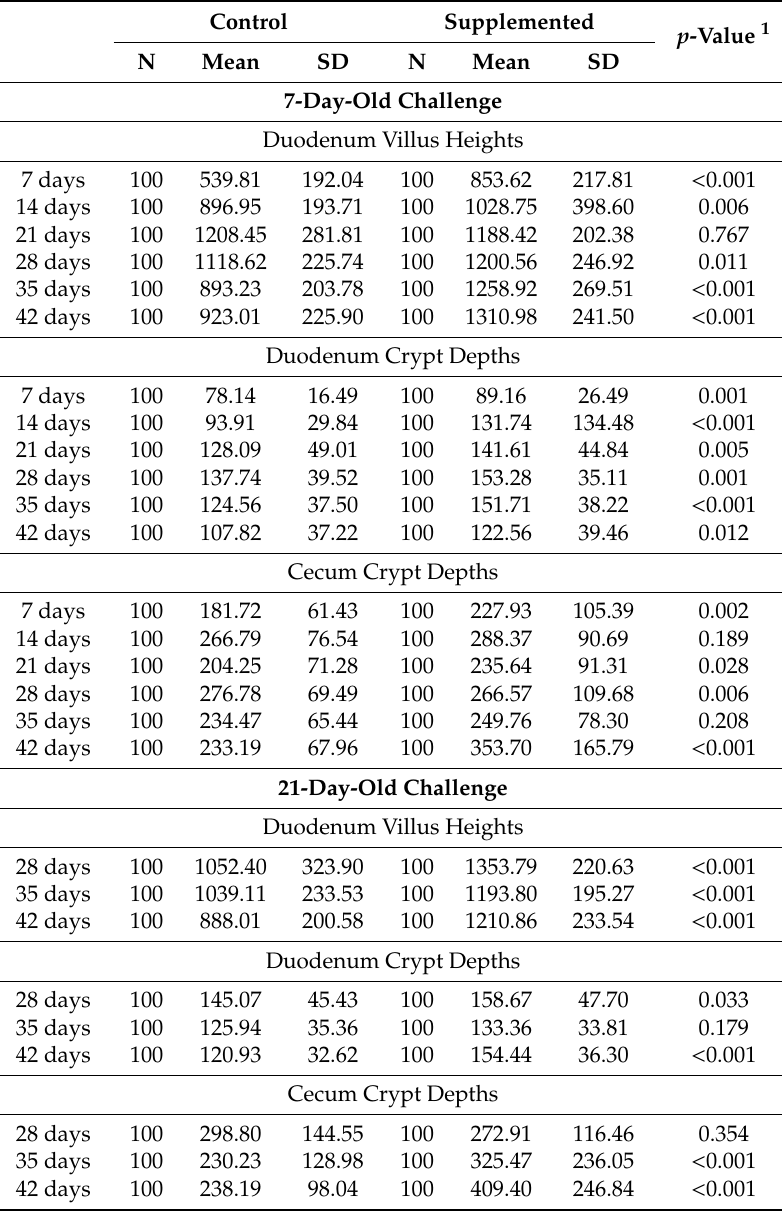
Table 5. Histomorphometric results: duodenum villi height, duodenum crypt depth and ceca crypt depth. Number of samples (N), mean values (mean), standard deviation (SD), and p -value are detailed per day of life and challenge